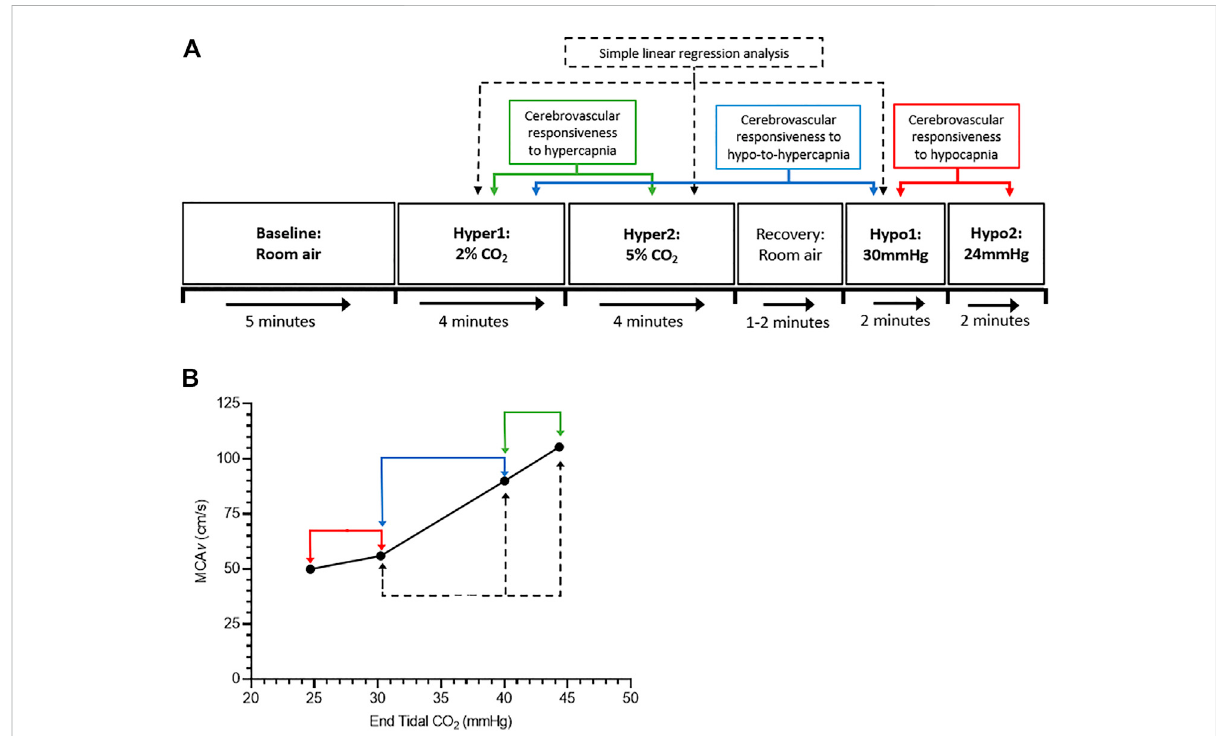
FIGURE 1 Schematic of the study protocol. (A) shows the cerebrovascular-CO 2 responsiveness tests protocol, and (B) shows an example graph of the cerebrovascular-CO 2 responsiveness slope. Green, blue, and red arrows indicate points of data extraction to calculate the cerebrovascular responsivenesstohypercapnia(Hyper1toHyper2),hypo-to-hypercapnia(Hypo1toHyper1),andhypocapnia(Hypo1toHypo2),respectively.Dashed back arrows indicate points of data extraction used in simple linear regression